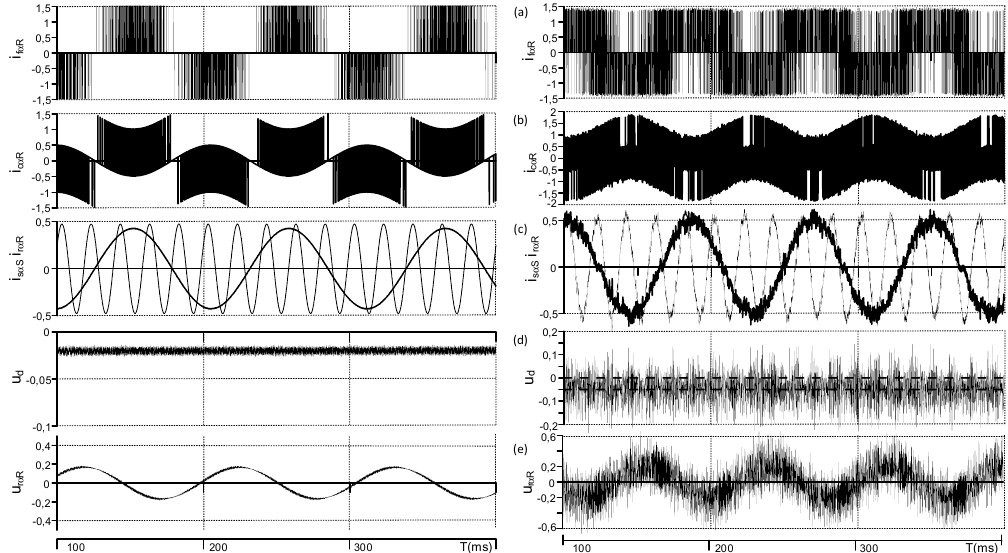
Figure 5. Simulation results: steady-state transients for different values of output passive filter capacitance: ( left ) L d = 0.05, C m = 0.35; ( right ) L d = 0.05, C m = 0.1. ( a ) Vector component of the output current inverter; ( b ) vector component of the output current filter; ( c ) vector components of the stator and rotor currents; ( d ) voltage in the DC link circuit; ( e ) rotor voltage component.